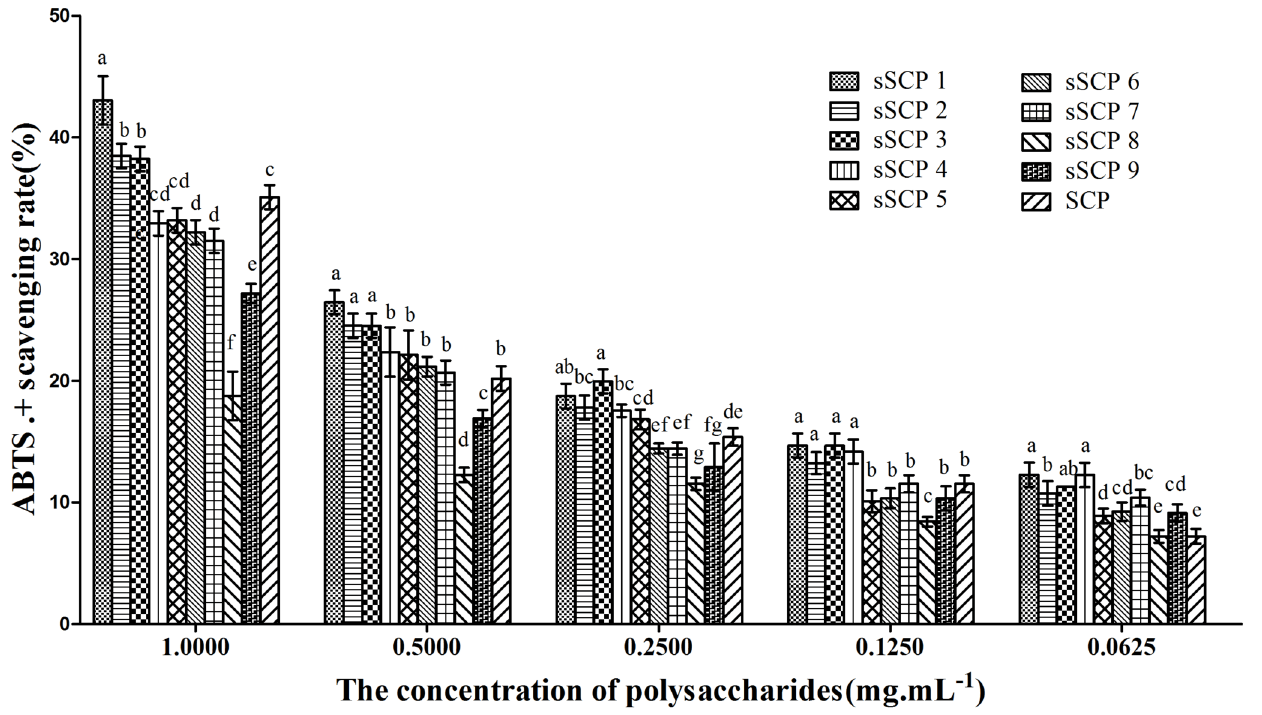
Fig 5. The ABTS radical- scavenging rates in each group at five concentrations. Bars in same concentration without same superscripts (a – g) differ significantly ( P < 0.05).